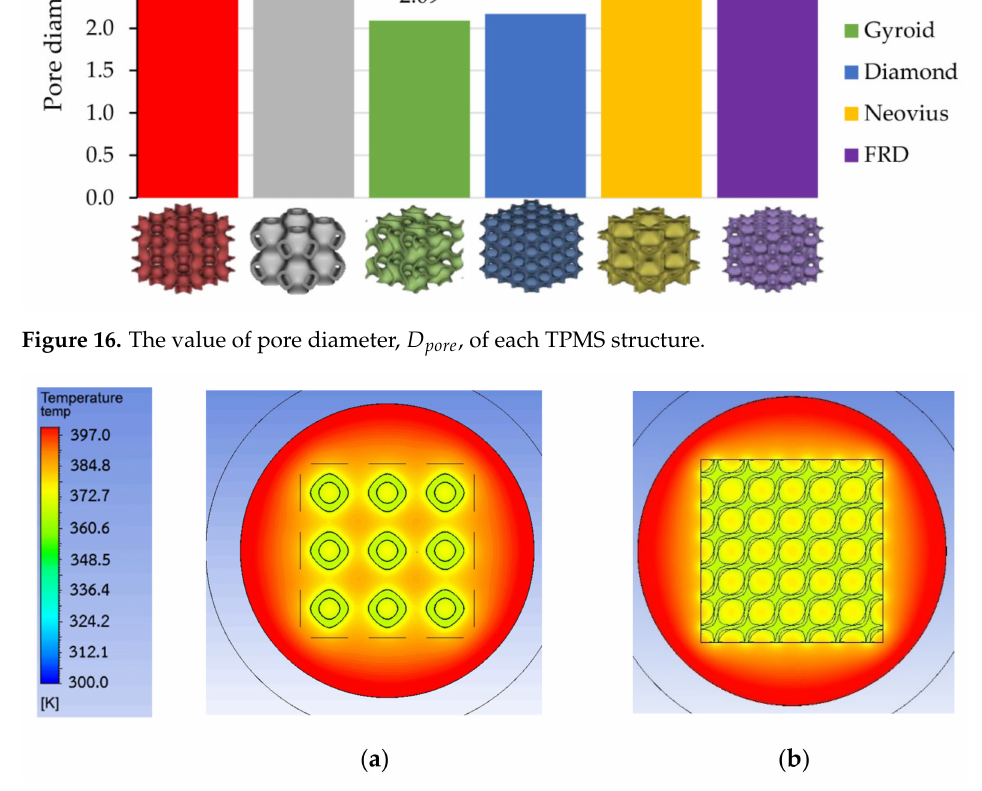
Figure 17. Temperature contours of membrane inlet surface between: ( a ) Primitive; ( b )